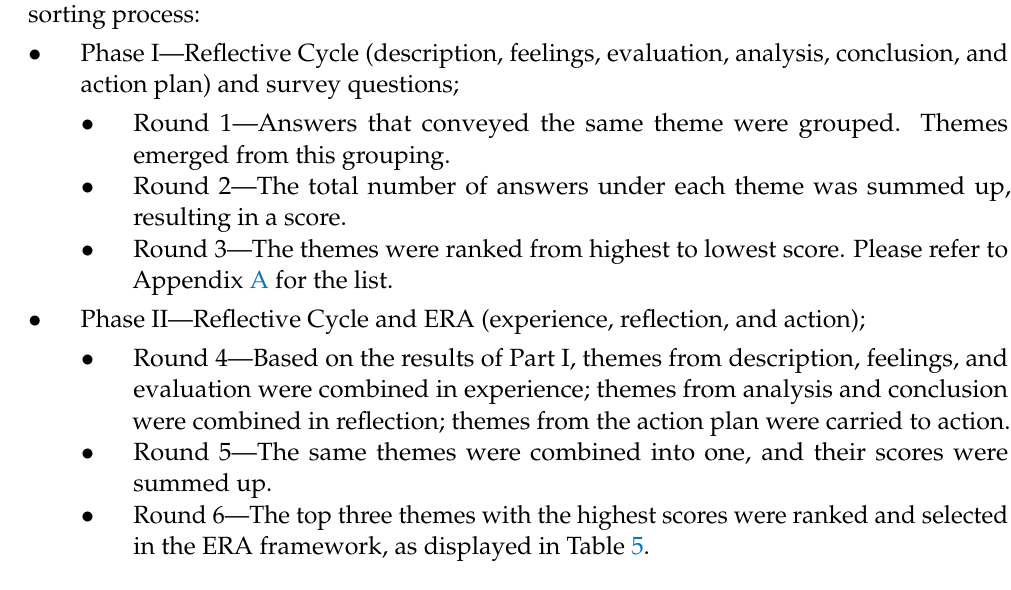
Figure 1. ERA, Reflective Cycle, and survey questions’ data-sorting process. The length of the answers to the open-ended questions varied from one word to long, reflective paragraphs. As illustrated in Figure 1, these answers went through a two-phase sorting